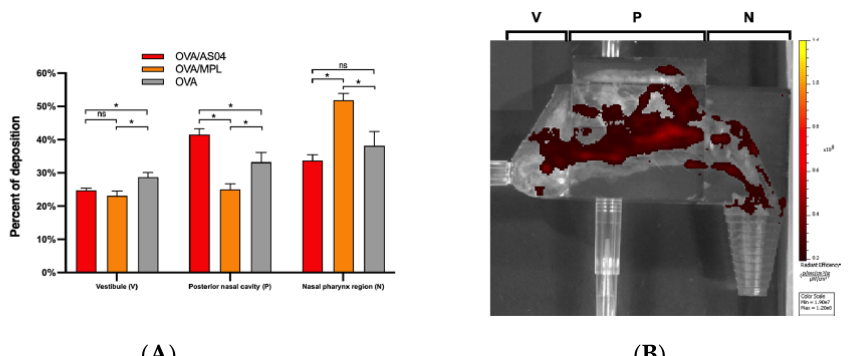
Figure 7. Intranasal deposition of three OVA antigen formulations in a nasal cast representative of a 7-year-old girl ( A ). The administration angle was 40° from the horizontal. Distribution ( B ) is shown in the vestibule (V), posterior region (P) and nasopharynx (N) from formulation OVA/AS04 [32] (ns: not significant, * p <